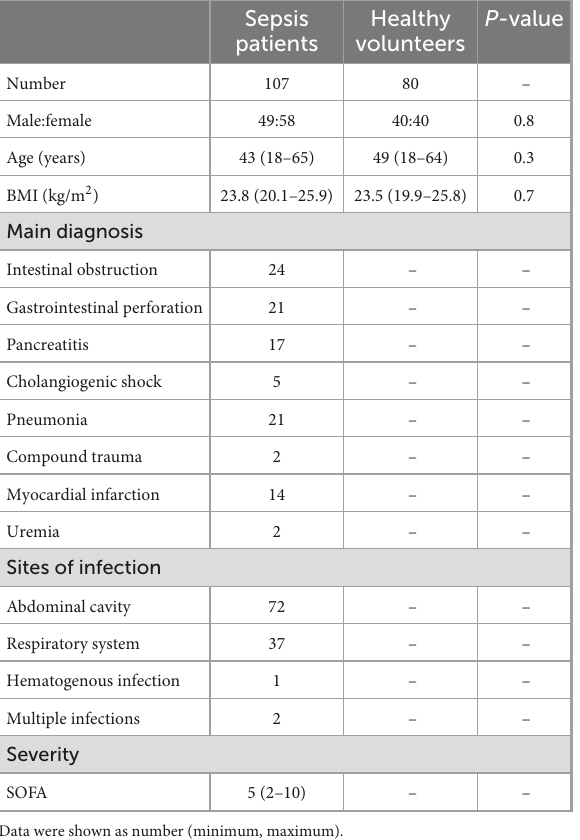
Sepsis Healthy P patients volunteers